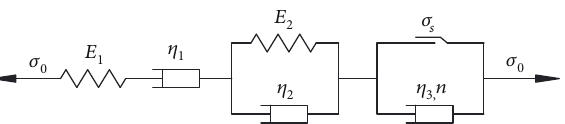
Figure 9: An improved nonlinear viscoelastoplastic rheological model based on burgers Table 3: Parameters of improved nonlinear viscoelastoplastic rheological model based on burgers model under 50% axial ultimate load (the creep duration under 5MPa con fi ning pressure is short, and there is too little data to be used for formula fi tting, so it is omitted).